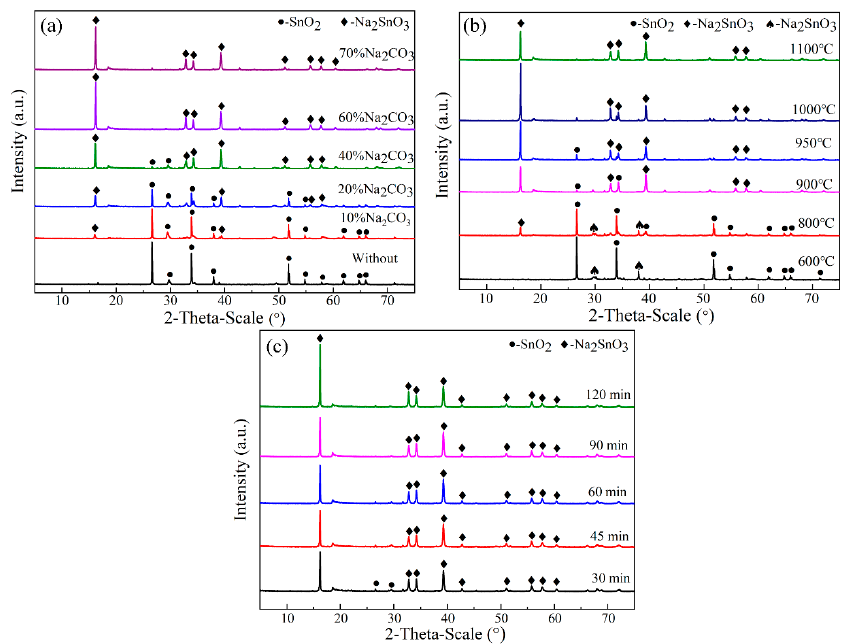
Figure 4. XRD patterns of the lead refining dross roasted at various conditions: ( a ) different Na 2 CO 3 ; ( b ) roasting temperature; ( c ) roasting time.